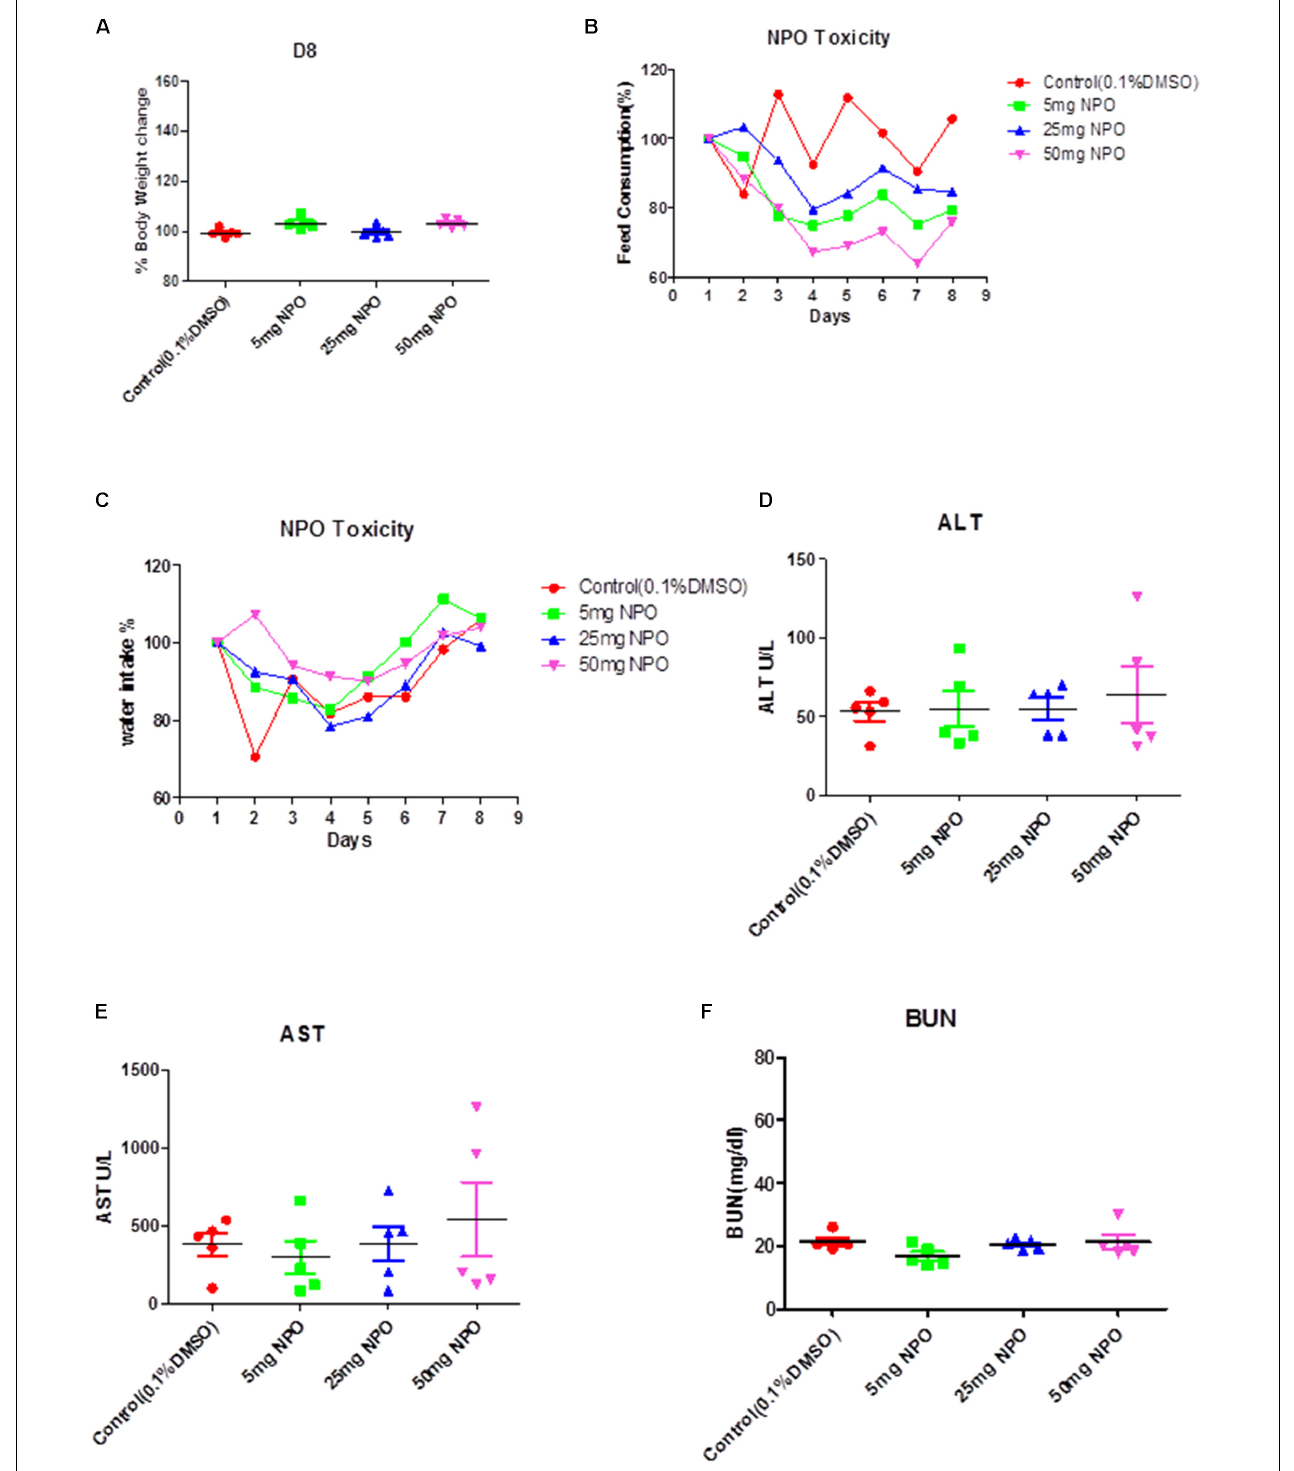
FIGURE 6 | Acute toxicity studies with NPO. (A) The effect of intraperitoneal administration of NPO on body weight change. The nude mice were treated with one single dose of NPO (5, 25, or 50 mg/kg). Error bars are means ± SD. Ordinary one-way ANOVA. (B,C) The effect of NPO on mice behavior study including feed consumption (B) and water intake (C) . Error bars are means ± SD. Ordinary one-way ANOVA. (D–F) Effect of NPO on biochemical parameters such as ALT, AST, and BUN levels. Error bars are means ± SD. Ordinary one-way ANOVA.